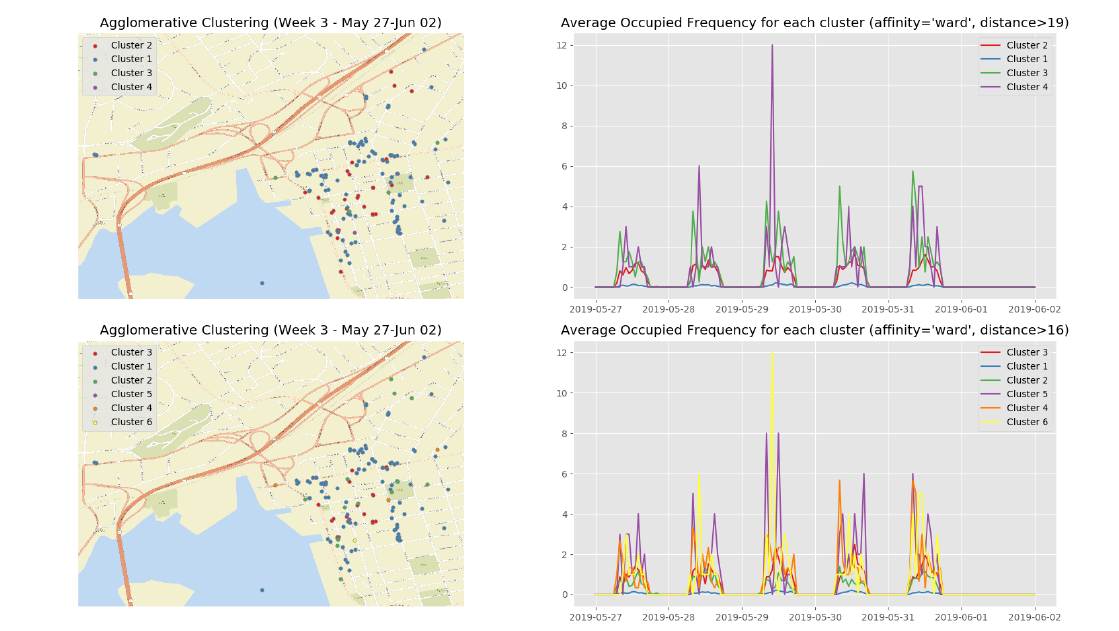
Figure A4. Clustering results for the 3rd week.